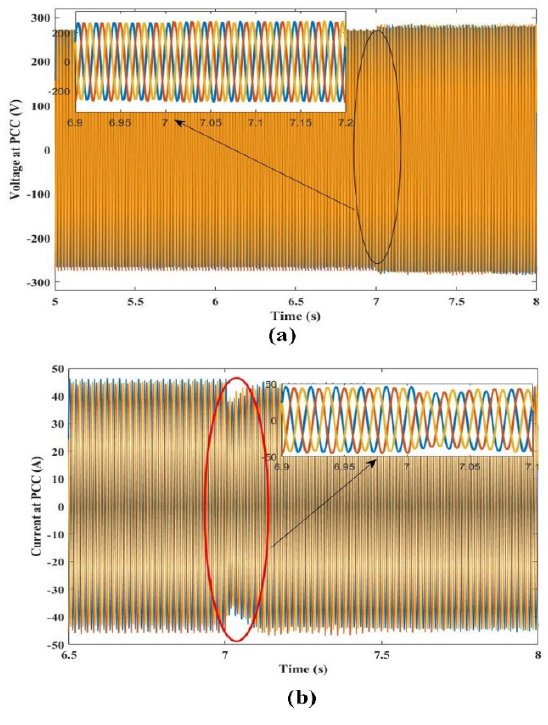
Figure 15. ( a ) Voltage and ( b ) Current at PCC for over-frequency event.